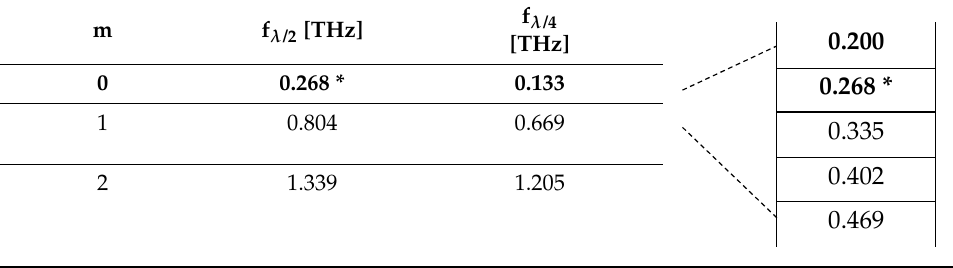
Table 1. The design frequencies for a multi-mode wave